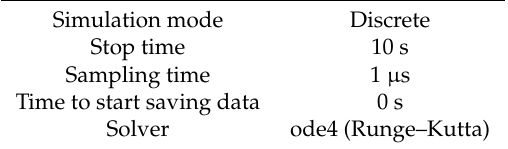
Table 5. Simulations parameters used in MATLAB